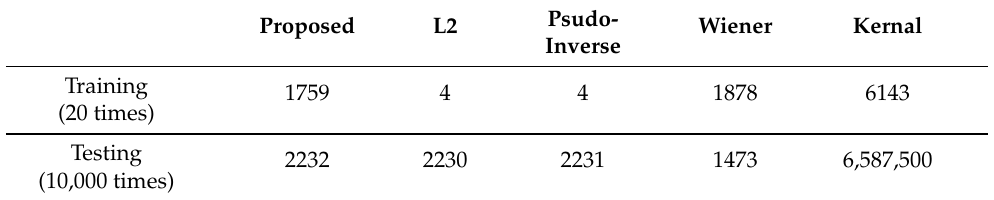
Table 2. Training and testing time of compared methods (Unit: ms)